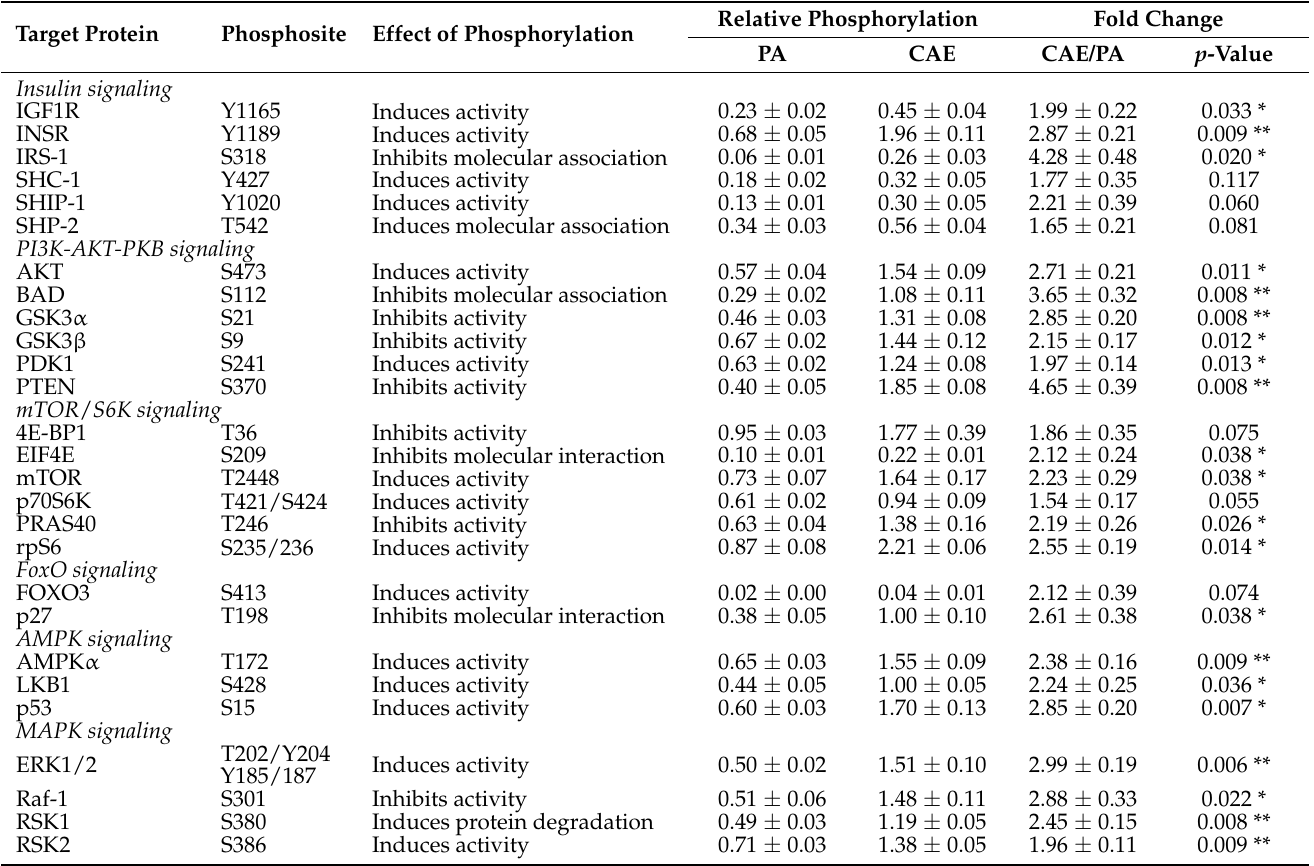
Table 1. Differential phosphorylation ratio of twenty-seven proteins related to the insulin, AKT, mTOR, FoxO, AMPK, and MAPK pathways in HepG2 cells in response to the treatment with palmitic acid (PA, 500 µ mol L − 1 ) and the co-treatment with PA and the phytochemical-rich aqueous extract from the cocoa shell (CAE, 100 µ g mL − 1